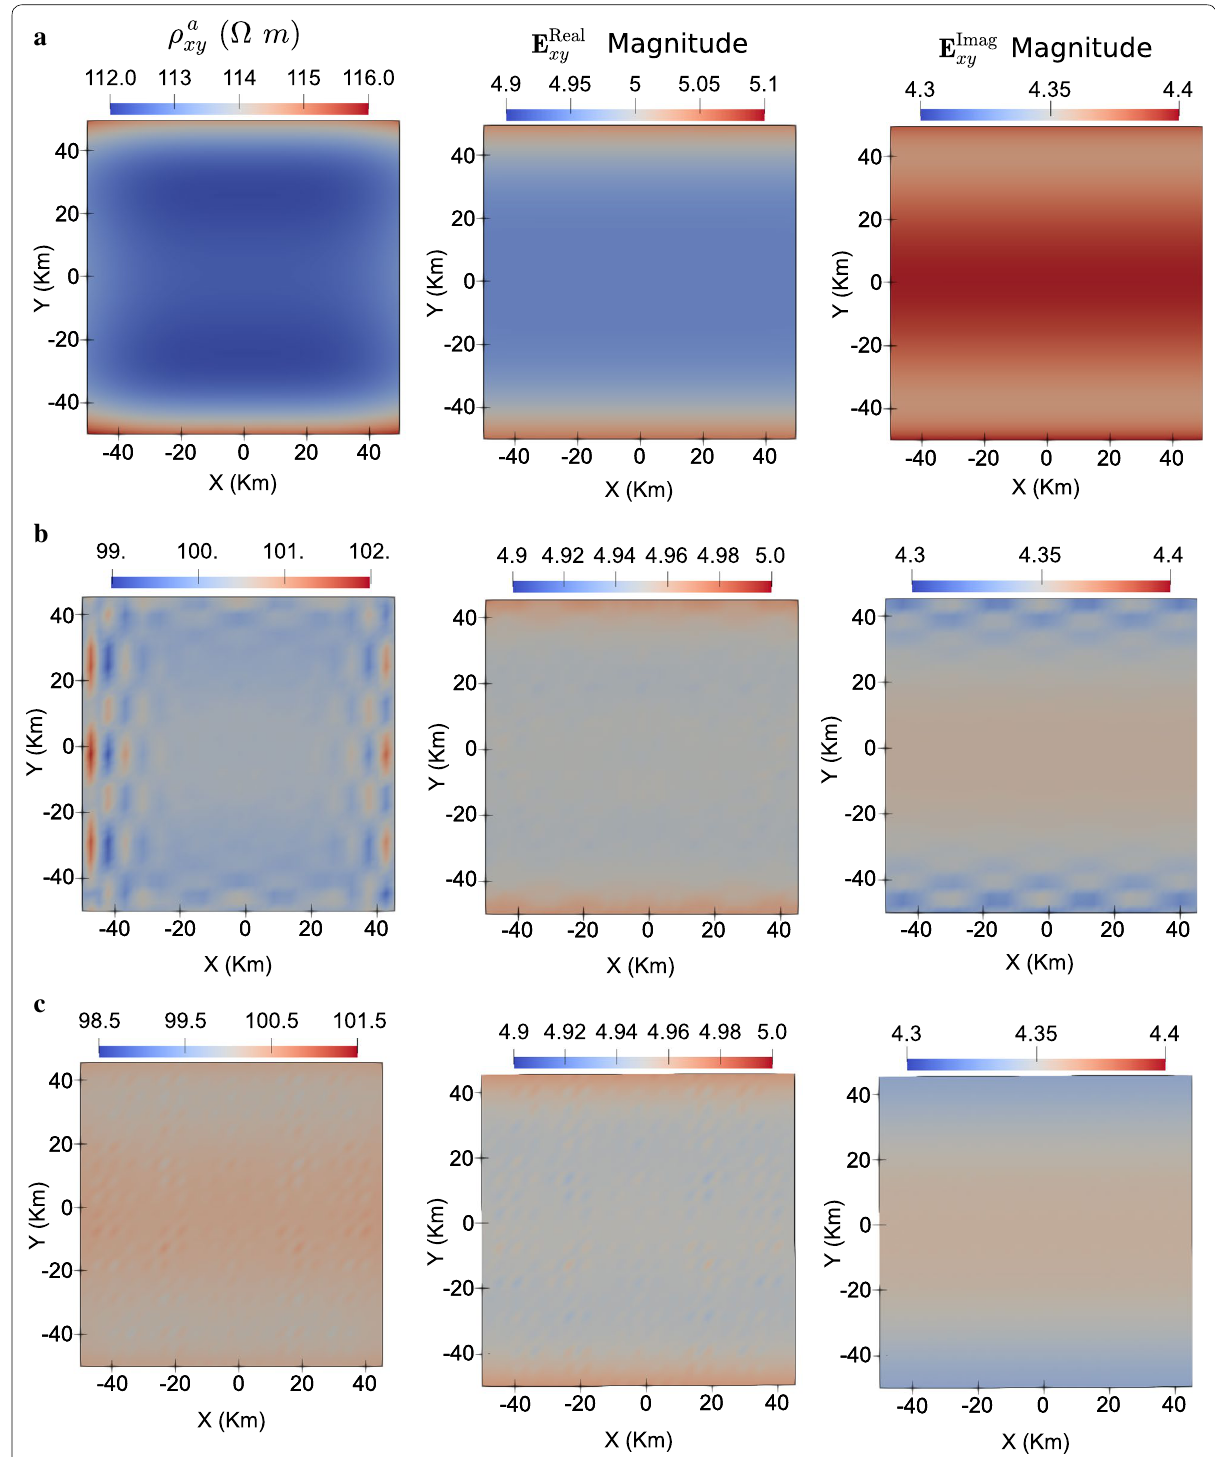
Fig. 7 Electric field solution for all elements. Surface view of resistivity (left panel), real electric field (central panel), and imaginary electric field (right panel). a Linear elements, b quadratic elements, and c Lagrangian